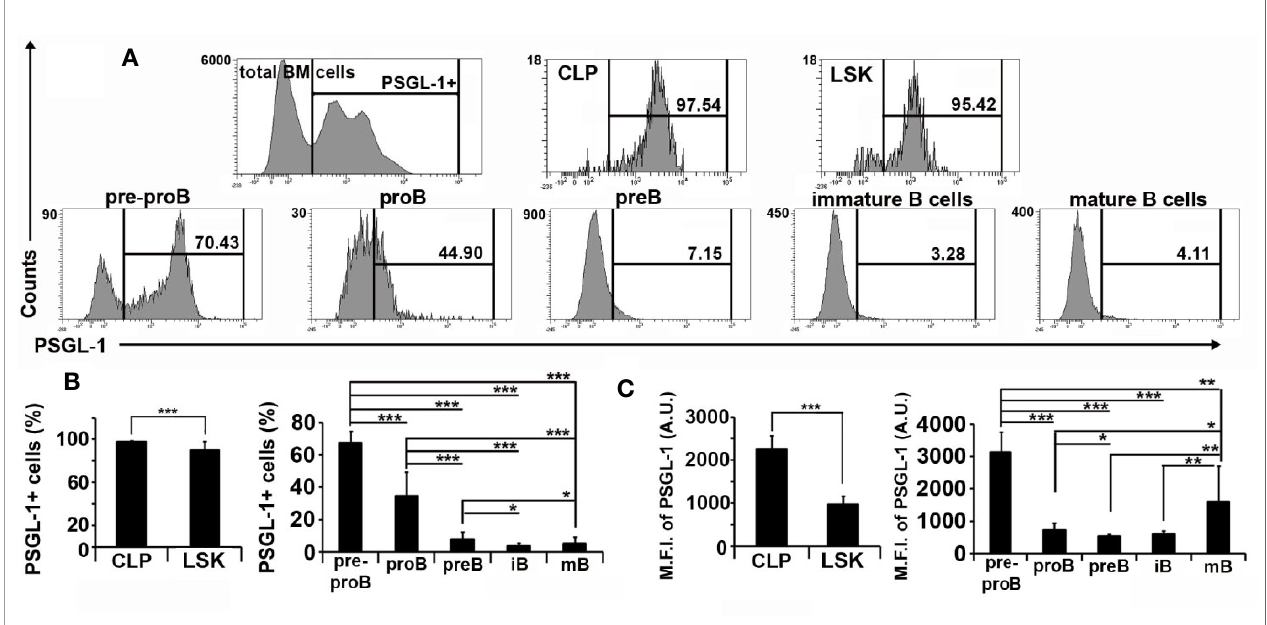
FIGURE 3 | PSGL-1 expression is gradually down-regulated throughout B cell development. (A) Representative histograms showing PSGL-1 expression in total bone marrow cells, Lin − Sca-1 + c-KIT + (LSK), common lymphoid progenitors (CLP), pre-pro B cells, pro-B cells, pre-B cells, immature (iB) B cells, and mature (mB) B cells of WT mice. (B, C) Percentage of PSGL-1 expressing cells (B) and PSGL-1 mean fl uorescence intensity (MFI) (C) among the different bone marrow precursors and B cell lineage-committed subsets of WT mice. Bars represent the mean+standard deviation. *p < 0.05, **p < 0.01, ***p < 0.001 by Kruskal-Wallis test. In all cases, n = 12 mice per